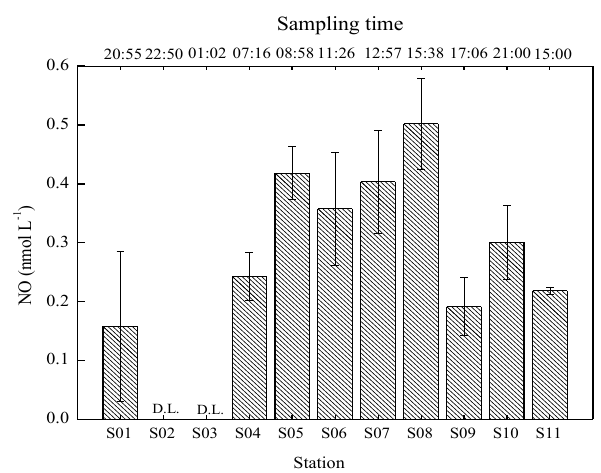
Figure 5. The concentrations of NO in the surface water off Qing- dao and Jiaozhou